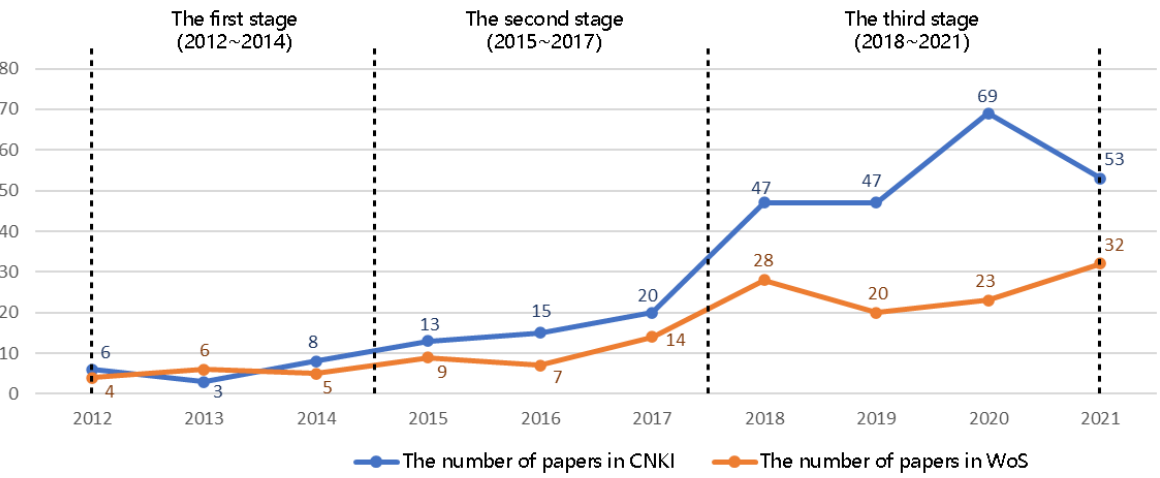
Figure 1. Annual changes of literature related to the digital landscape architecture heritage protection.